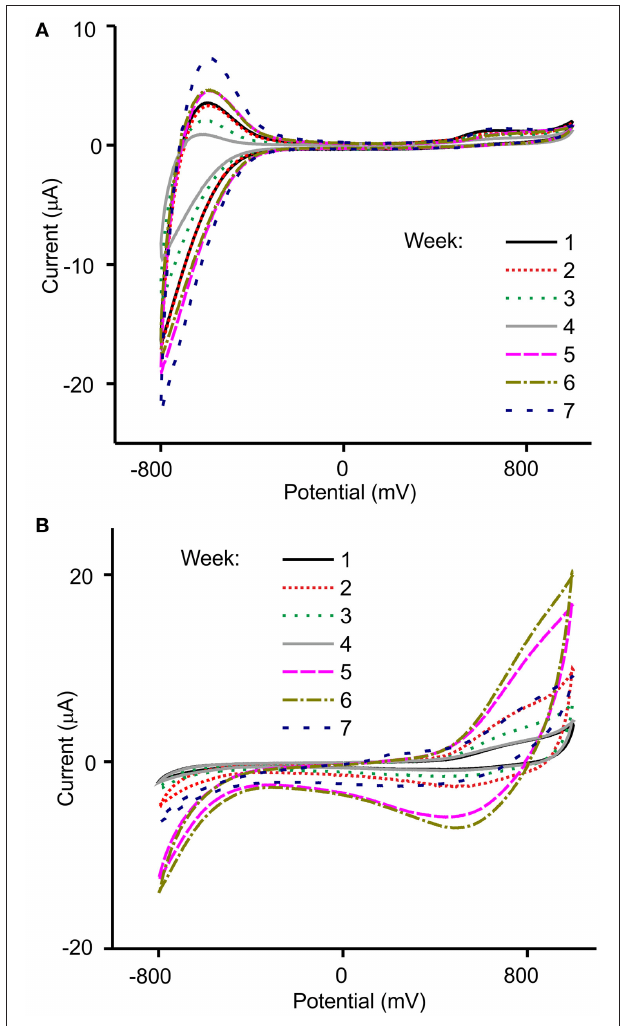
FIGURE 6 | Voltammetric responses of (A) TiO 2 NP-CPE and (B) NiONP-CPE electrodes toward Garnacha grapes collected weekly after véraison .